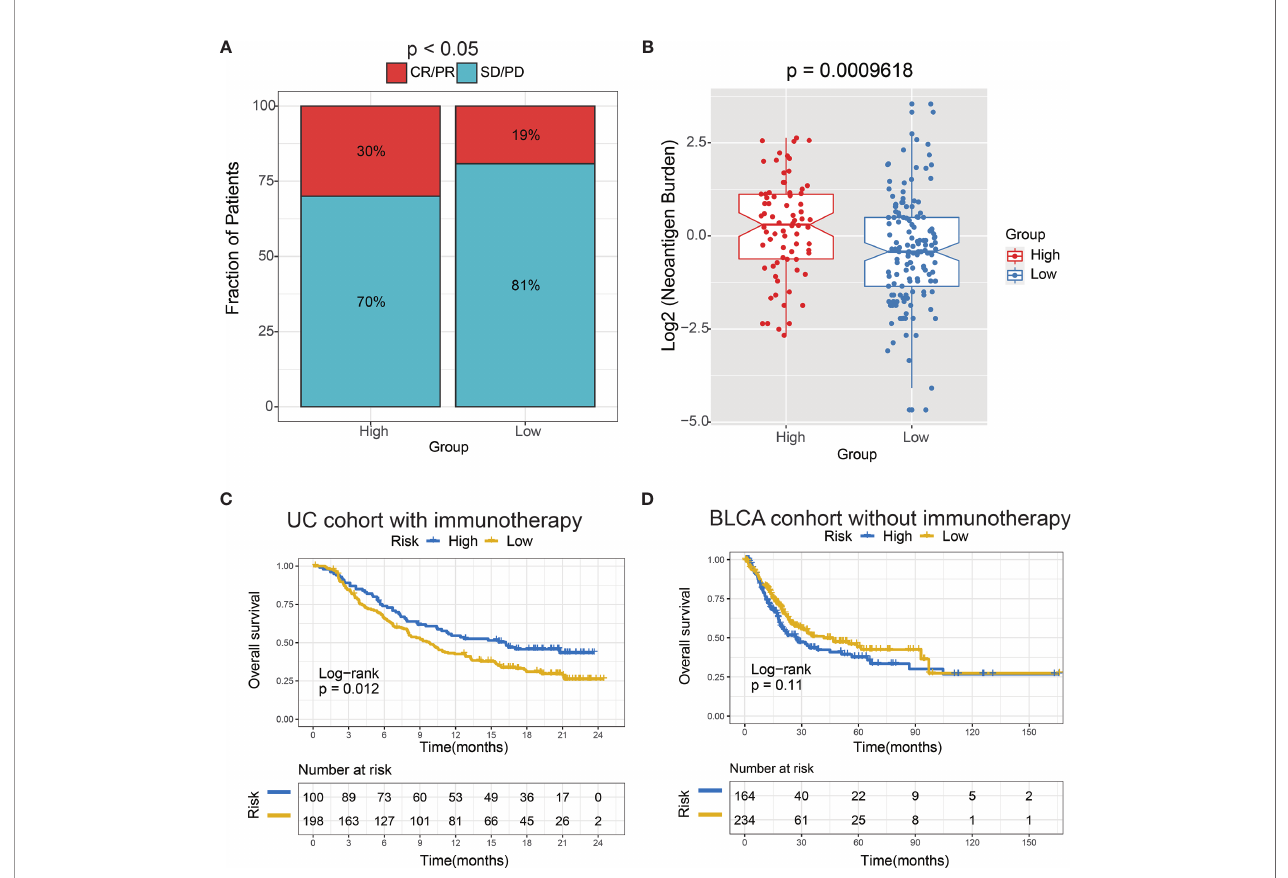
FIGURE 8 | The 6-lncRNA signature in the role of immunotherapy. (A) The proportion of immune response to immunotherapy in high versus low immune risk score subgroups. CR, complete response; PR, partial response; SD, stable disease; PD, progressive disease. (B) Neoantigen burden in the UC cohort was compared among the distinct 6-lncRNA signature subgroups. (C) Kaplan – Meier analysis of the high versus low immune risk subgroup in the UC cohort. (D) Kaplan – Meier analysis of the high versus low immune risk subgroup in the BLCA